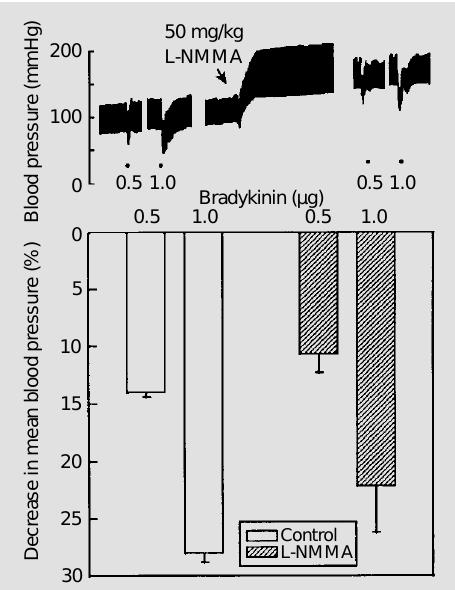
1 - Hypotensive effect of bradykinin (0.5 and 1.0 µg) be- fore and after intravenous ad- ministration of the NO synthase inhibitor L-NMMA (50 mg/kg) in conscious normal male rats. The upper panel shows a represen- tative tracing of directly recorded arterial blood pressure. The lower panel shows the mean ± SEM values (N = 4) of the hy- potensive effect expressed as percentage of pre-bradykin injec- tion mean blood